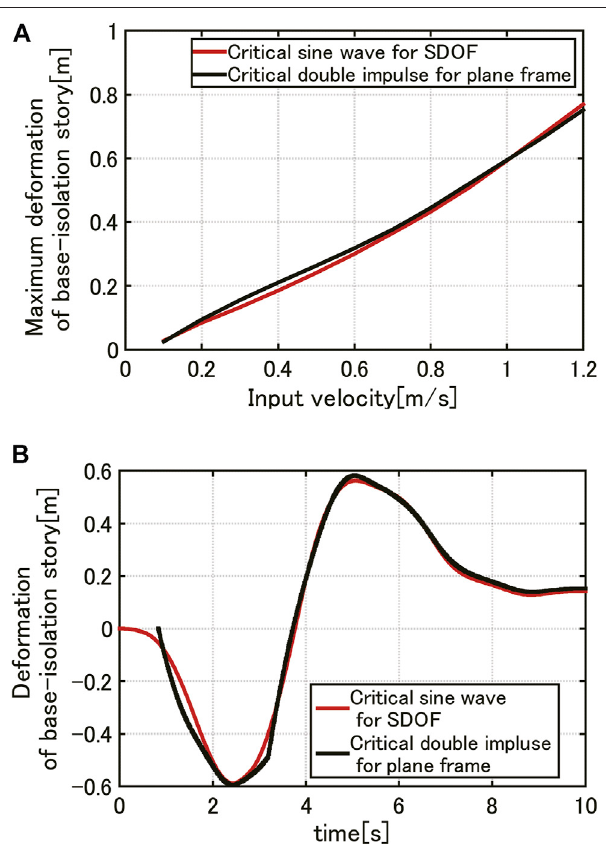
FIGURE 12 | Comparison of deformation of the base-isolation story of plane frame model under one-cycle sine wave equivalent to the critical double impulse for SDOF model with that under critical double impulse (a pair of inverse-direction one-point acceleration inputs) for plane frame model, (A) Maximum deformation of base-isolation story, (B) Time history of deformation of the base-isolation story (input velocity level V (cid:2) 1.0 [m/s]).